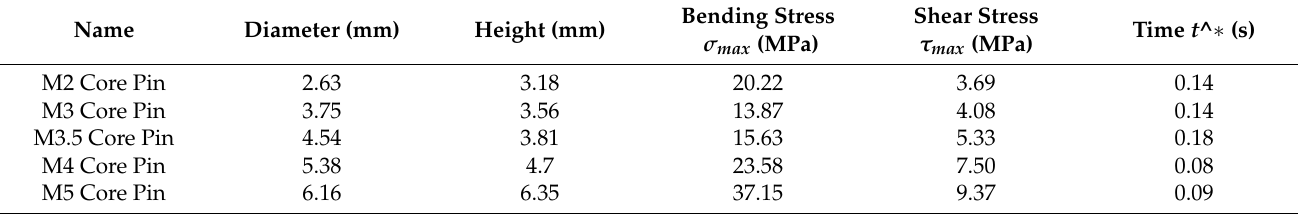
Table 7. Bending and shear stresses on the core pin with the effective diameter and yield strength of the tool